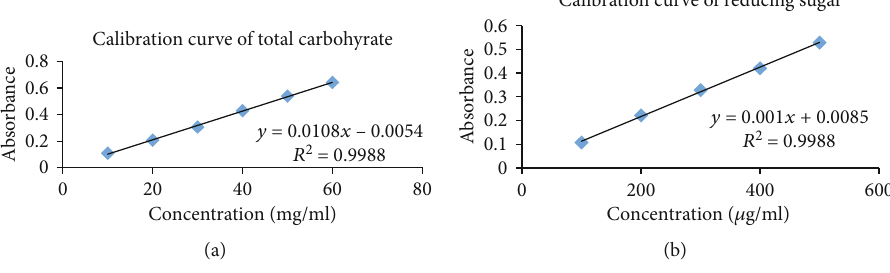
Figure 1: (a) Standard calibration curve of total carbohydrate. (b) Standard calibration curve of reducing sugar. Table 1: Dietary fi ber in sample cooked in LPG gas and fi